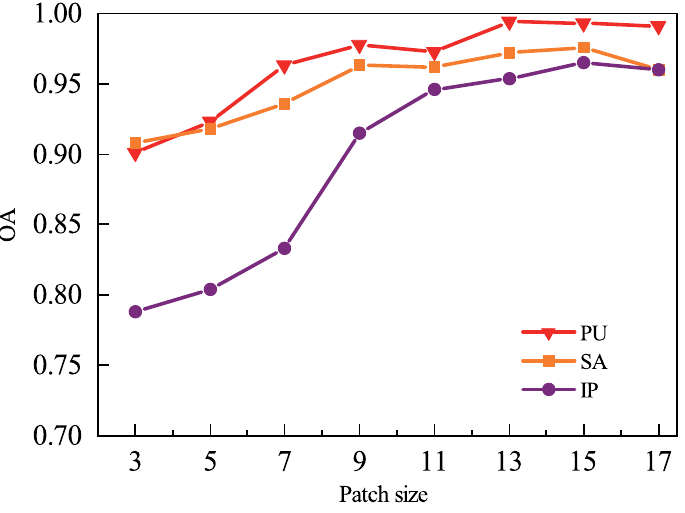
Figure 5. OA of NEHT network with different patch size in the PU, SA and IP data